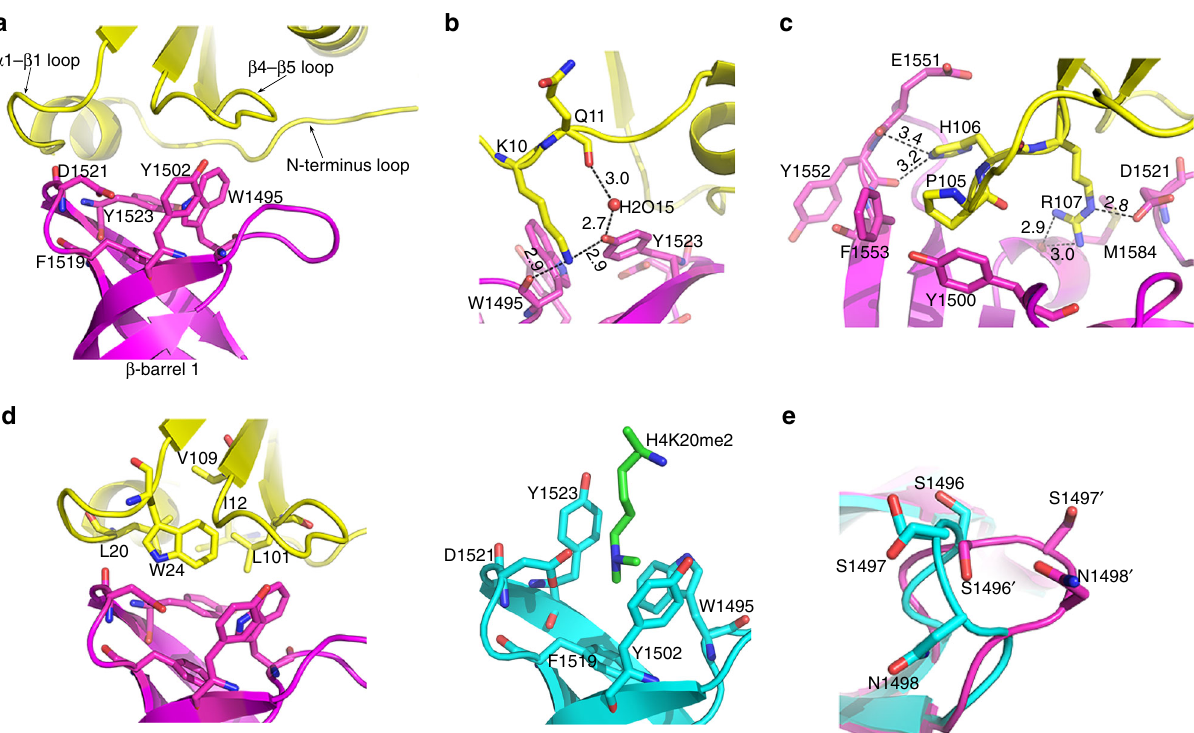
Fig. 2 Detailed view of TIRR (yellow) binding to 53BP1 TTD (magenta). a Three loops from TIRR are involved in the interaction with the dimethyl-lysine binding pocket of 53BP1 TTD. The three loops are labeled as N-terminus loop, α 1- β 1 loop, and β 4- β 5 loop respectively. The dimethyl-lysine binding pocket is from the β -barrel 1 of the TTD, the fi ve residues representing the pocket are labeled. b Interaction details of TIRR Lys 10 with 53BP1 TTD. Lys 10 and Gln 11 from TIRR are in yellow stick, Tyr 1523 and Trp 1495 from the TTD are in magenta stick, and the water molecule is in red sphere. The hydrogen bonds are shown as dashed lines. c Interaction details of TIRR Pro 105 -His 106 -Arg 107 with 53BP1 TTD. The three residues Pro 105 , His 106 , and Arg 107 from TIRR are displayed in yellow stick. The corresponding interacting residues from TTD are shown in magenta stick. The hydrogen bonds are shown as dashed lines. d Structural comparison of TIRR and H4K20me2 binding to the β -barrel 1 of 53BP1 TTD. Left: The TIRR hydrophobic layer consisting of fi ve residues covers the hydrophobic dimethyl-lysine binding pocket of 53BP1 TTD. Right: H4-K20me2 (green stick) binds to the dimethyl-lysine binding pocket of 53BP1 TTD (PDB ID: 2IG0). The residue H4-K20me2 is in green stick, and 53BP1 TTD is in cyan cartoon. e The subtle differences in the loop between β 1 and β 2 from the TTD molecule in the TIRR – 53BP1 TTD complex compared to that in the H4K20me2 – 53BP1 TTD complex (PDB entry 2IG0, cyan). Ser 1496 , Ser 1497 , and Asn 1498 are shown in